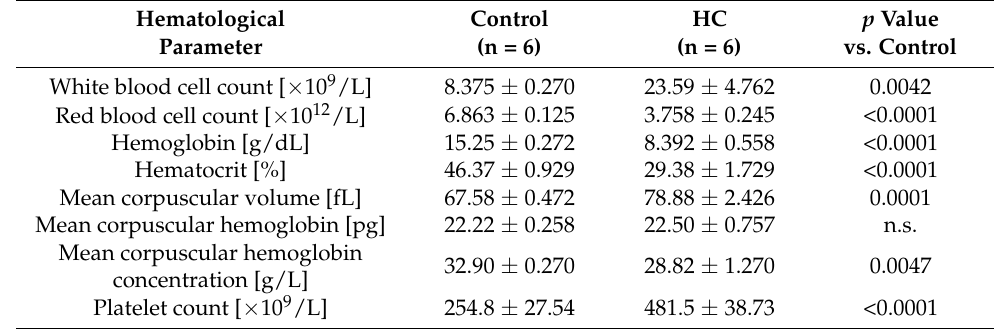
Table 1. Hematology parameters in the Control and the atherogenic groups (HC). Means ± SEM. Hematological